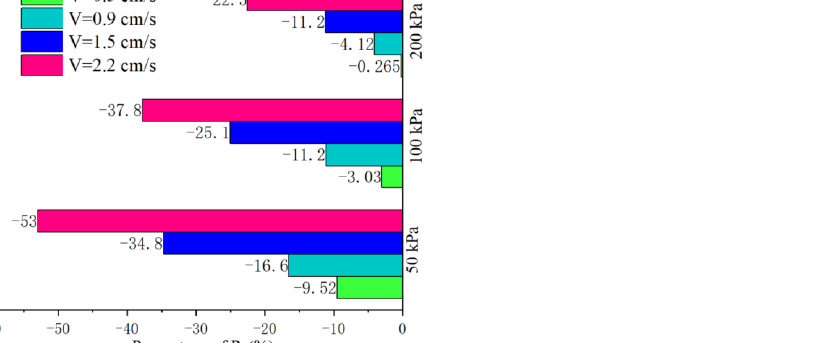
Figure 6. Comparison of the percentage reduction of the coordination number (the number of cyclic loading is 12,000).